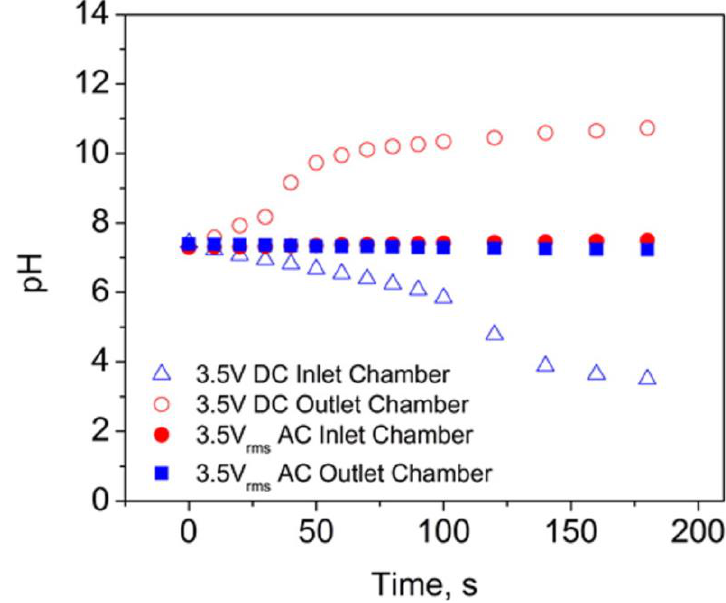
Figure 9. pH of the inlet and outlet chambers vs. time while driving EOF with 3.5 V DC and 3.5 V rms AC. Reprinted with permission from [11]. Copyright 2016, American Chemical Society.